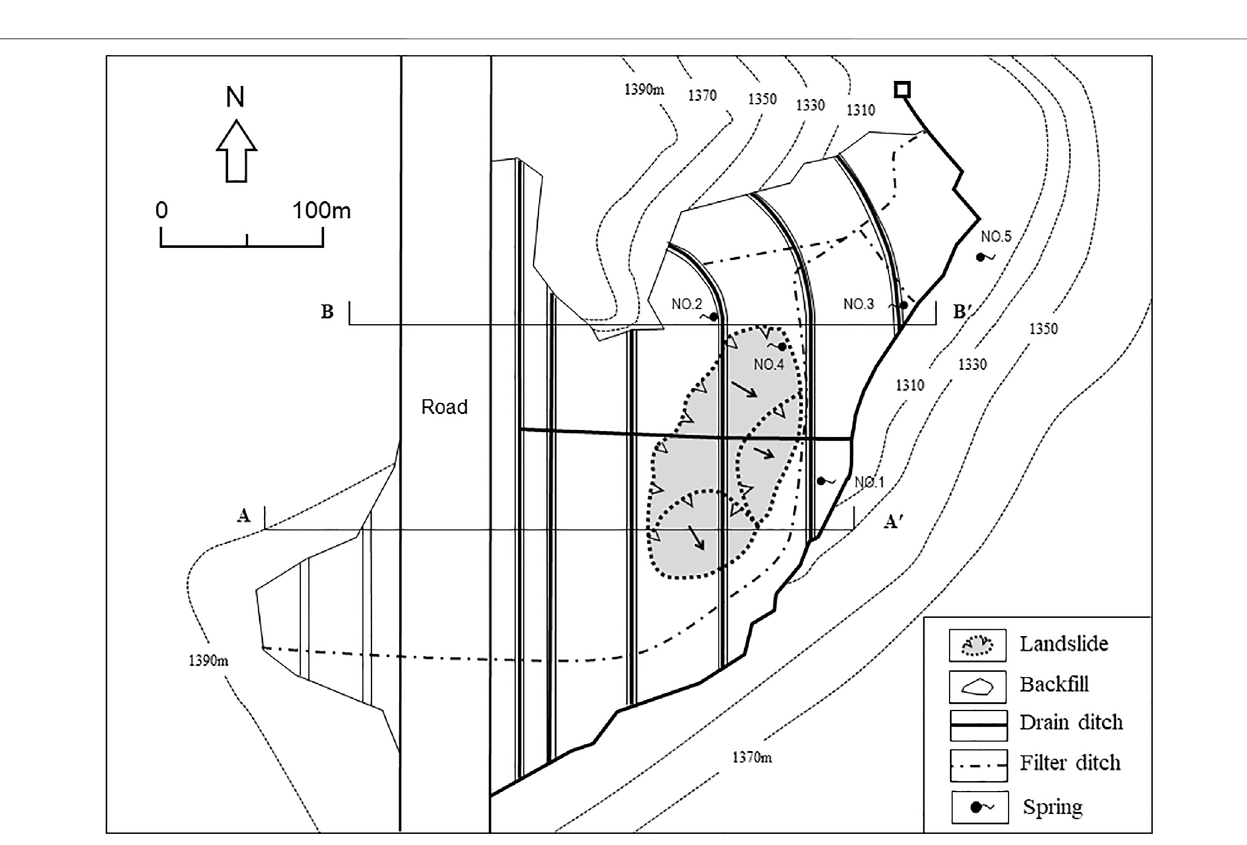
Frontiers in Earth Science |